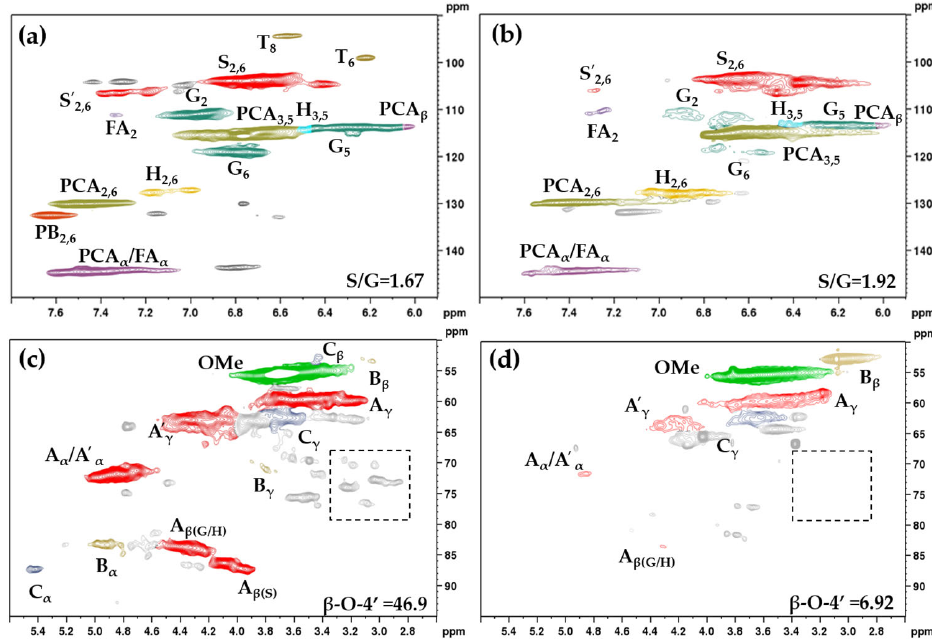
Figure 5. Two-dimensional Heteronuclear Single Quantum Coherence nuclear magnetic resonance (2D HSQC NMR) spectra of milled wood lignin (MWL) ( a , c ) and DES-L from ChCl-OA-MA ( b , d ).